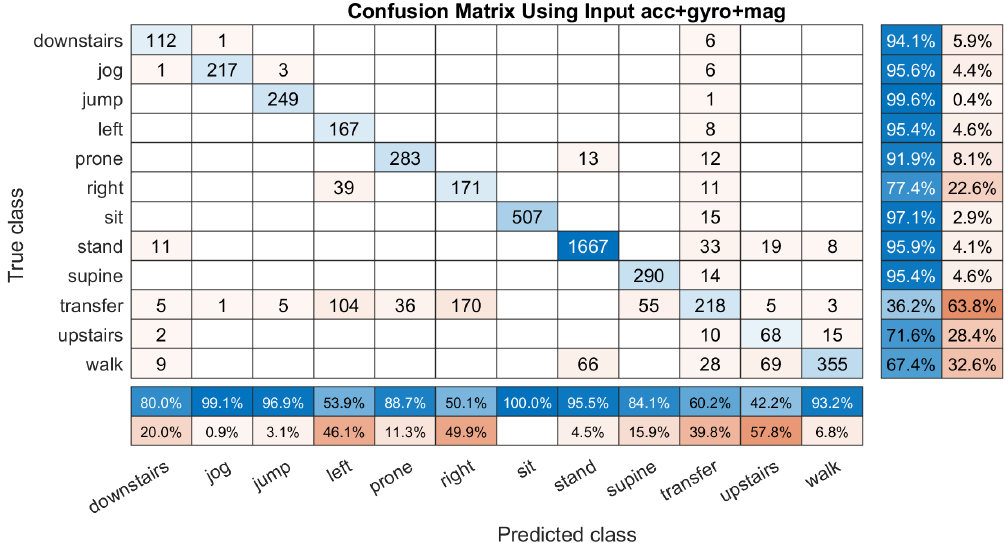
Figure 8. An example of the confusion matrix computed based on the input ’acc+gyro+mag’ (˜ s ∗ = { s α , s β , s γ } ). It have a column summary matrix and a row summary matrix to display the accuracy and the errors of each